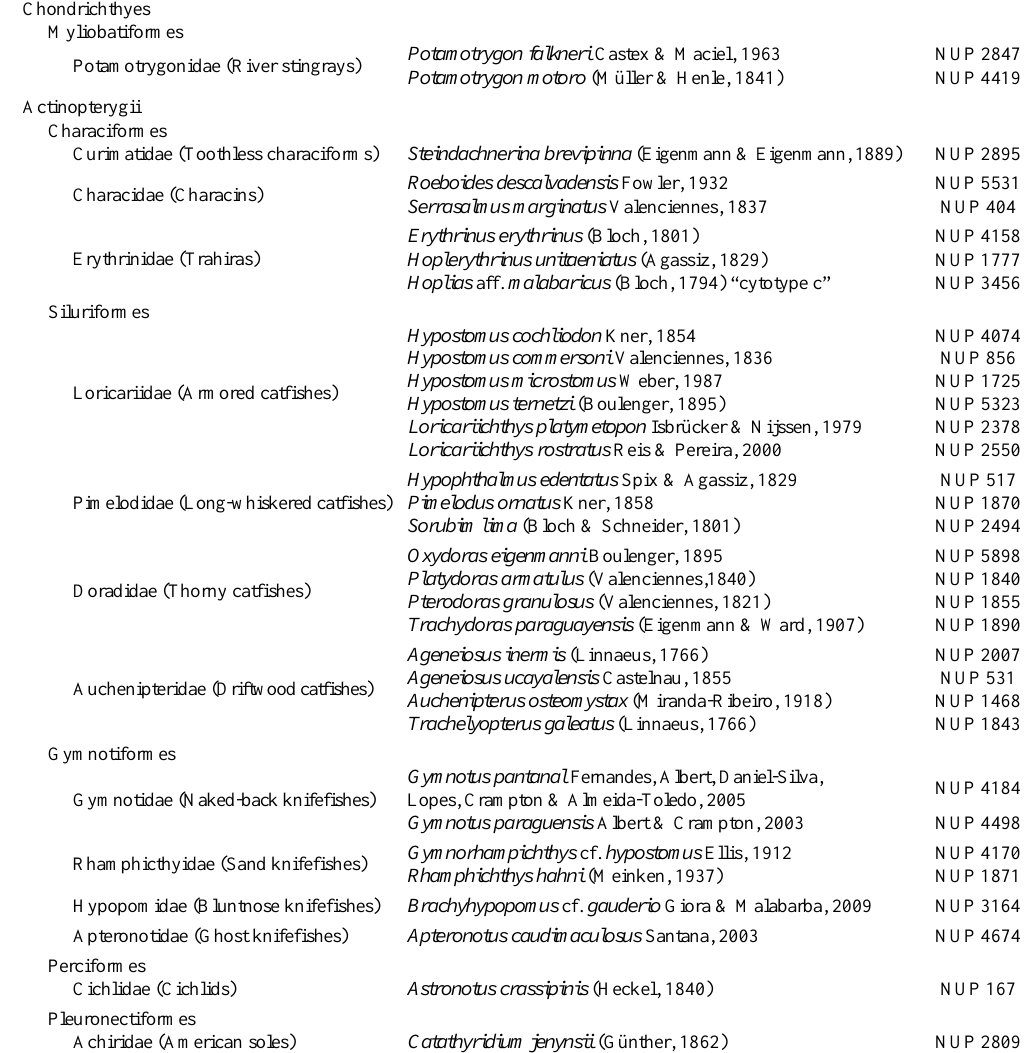
Table 1. Fish species from the lower Paraná River that successfully colonized the upper Paraná River ecoregion after the flooding of the geographical barrier of the Sete Quedas